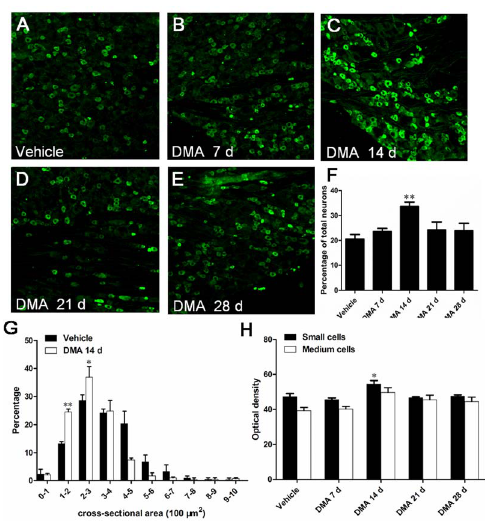
Figure 3. Immunofluorescent staining of TRPV1 and analysis of its expression pattern in DRG neurons at varying time points after the establishment of DMA. A–E , representative photographs of TRPV1 staining in DRG of different groups. F , illustration of the percentage of TRPV1-IR neurons over total neurons in vehicle, DMA 7 d, 14 d, 21 d and 28 d group (n=4–6). G , histogram for size distribution of TRPV1-IR neurons. Note the decreased distribution of TRPV1 in neurons with cross-sectional area larger than 400–500 and increased distribution of this protein within the range of 100–400 m m 2 (n=4–6). H , comparison of the optical density due to TRPV1 immunostaining in